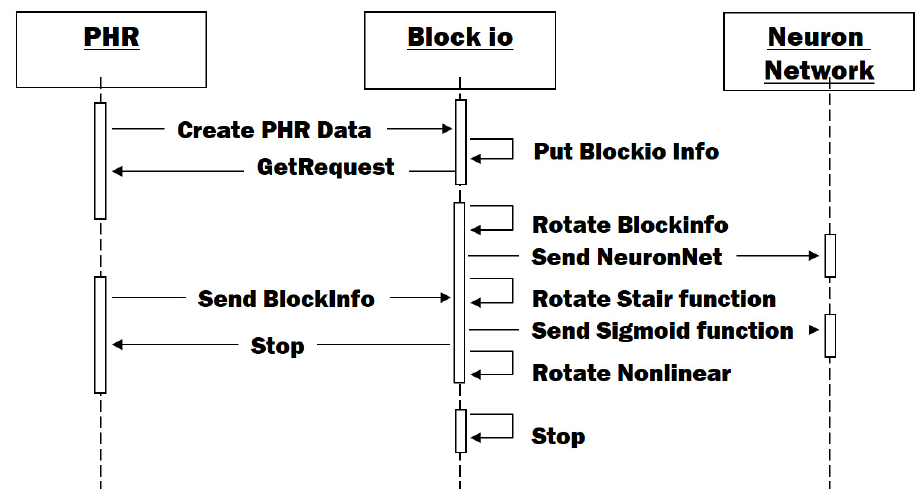
Figure 12. UML diagram, a neural network blockchain for phr verification (sequence diagram).